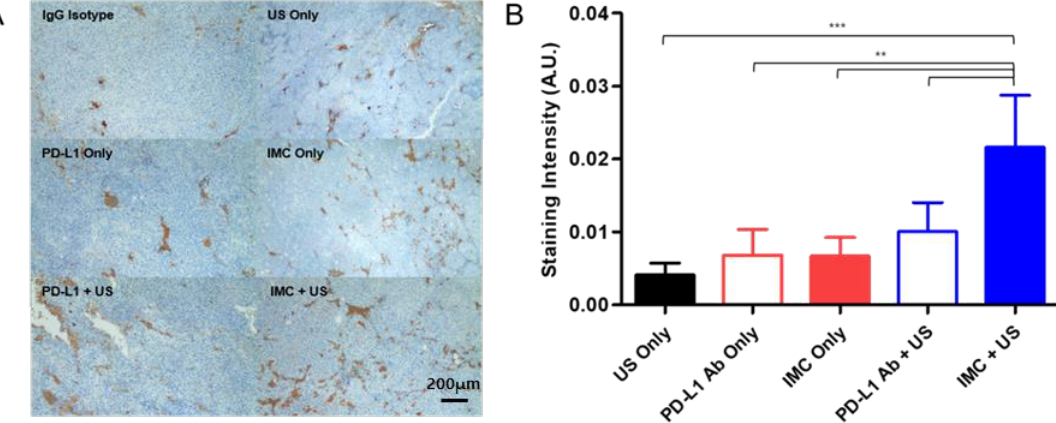
Figure 6. Immunohistochemical evaluation of different treatment groups. ( A ) Representative pictures for each treatment group after staining are presented. ( B ) The intensity of PD-L1 antibody staining from these pictures were analyzed using ImageJ. The staining intensity of the IgG isotype was subtracted from each group to account for the non-specific binding and background signals. Values are mean ± SD ( n = minimum 3 for each group). ** p ≤ 0.01, *** p ≤